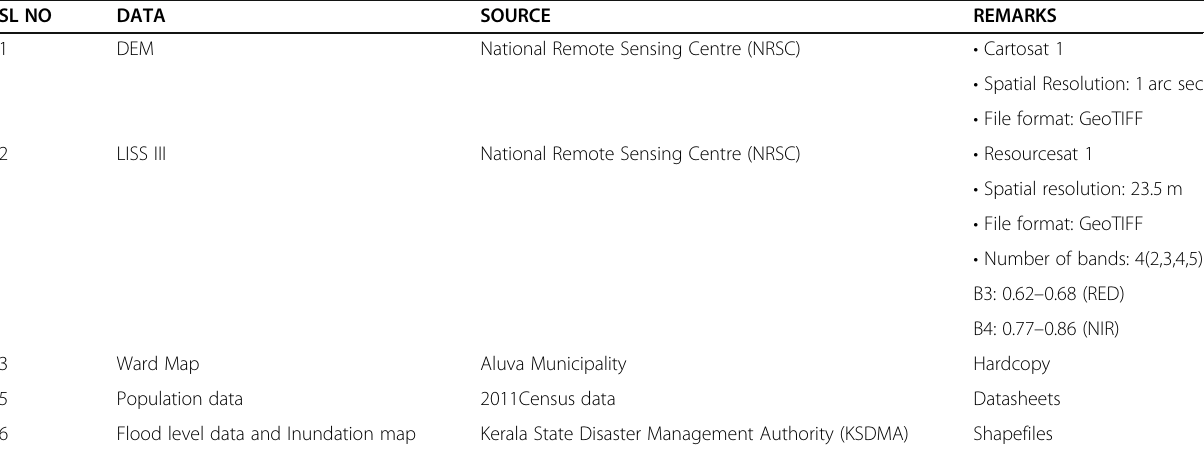
Table 1 Data used in the study SL NO